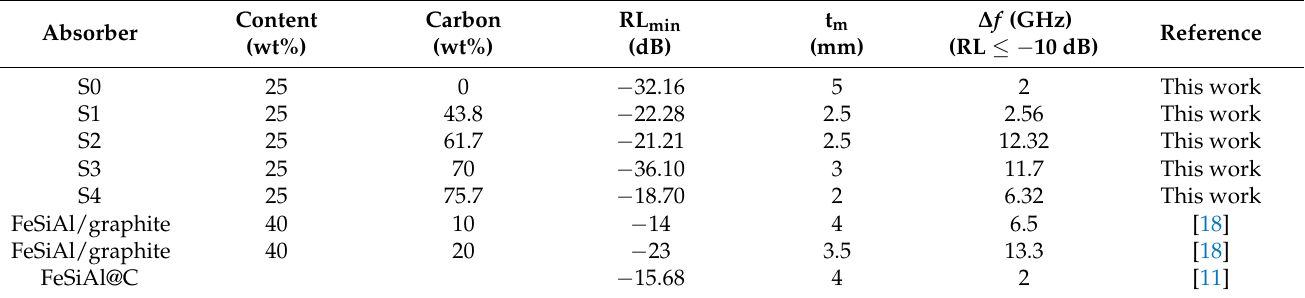
Table 2. Microwave absorption parameters of related absorbers.